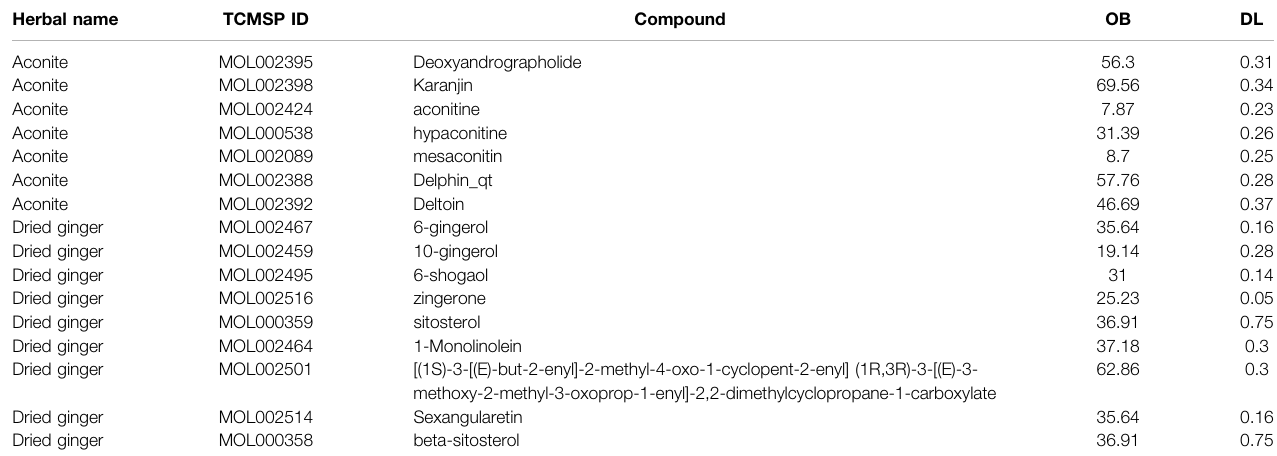
TABLE 1 | Information on the 16 active compounds in the